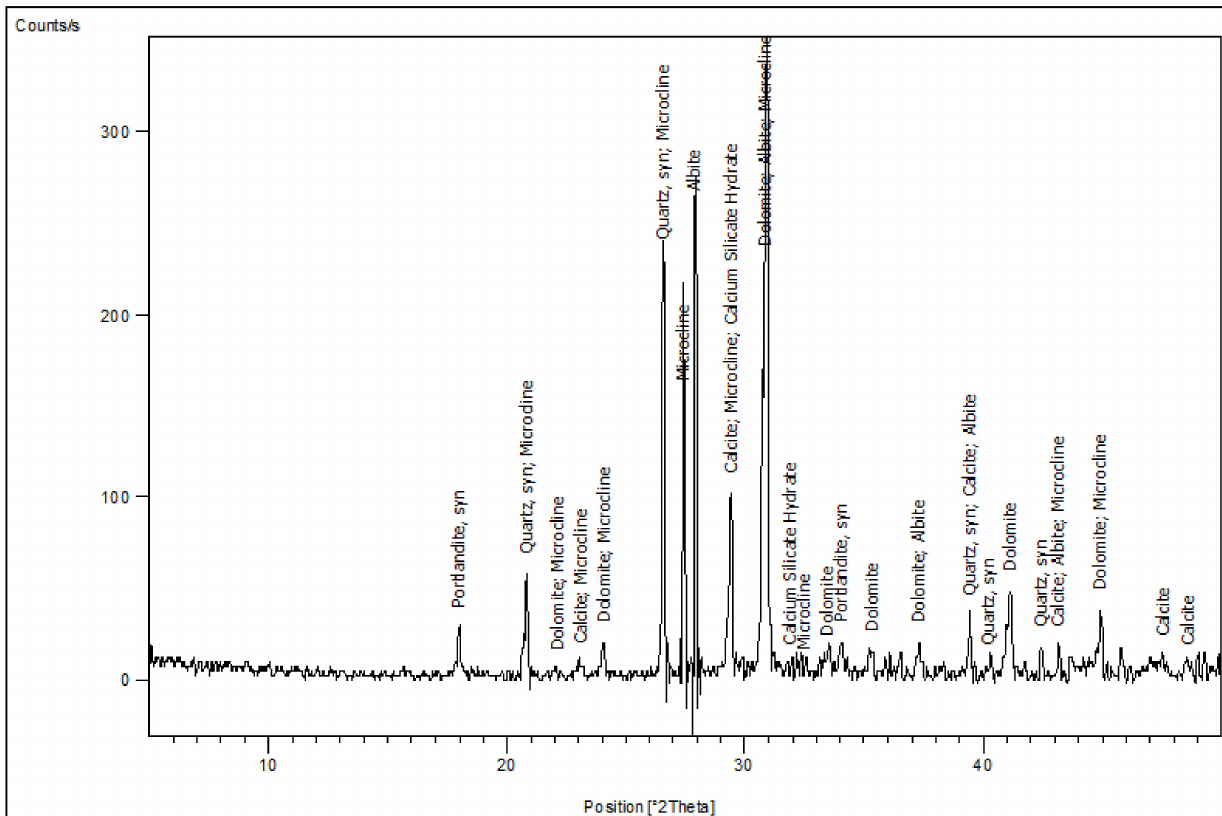
Figure 20. Z6 XRD